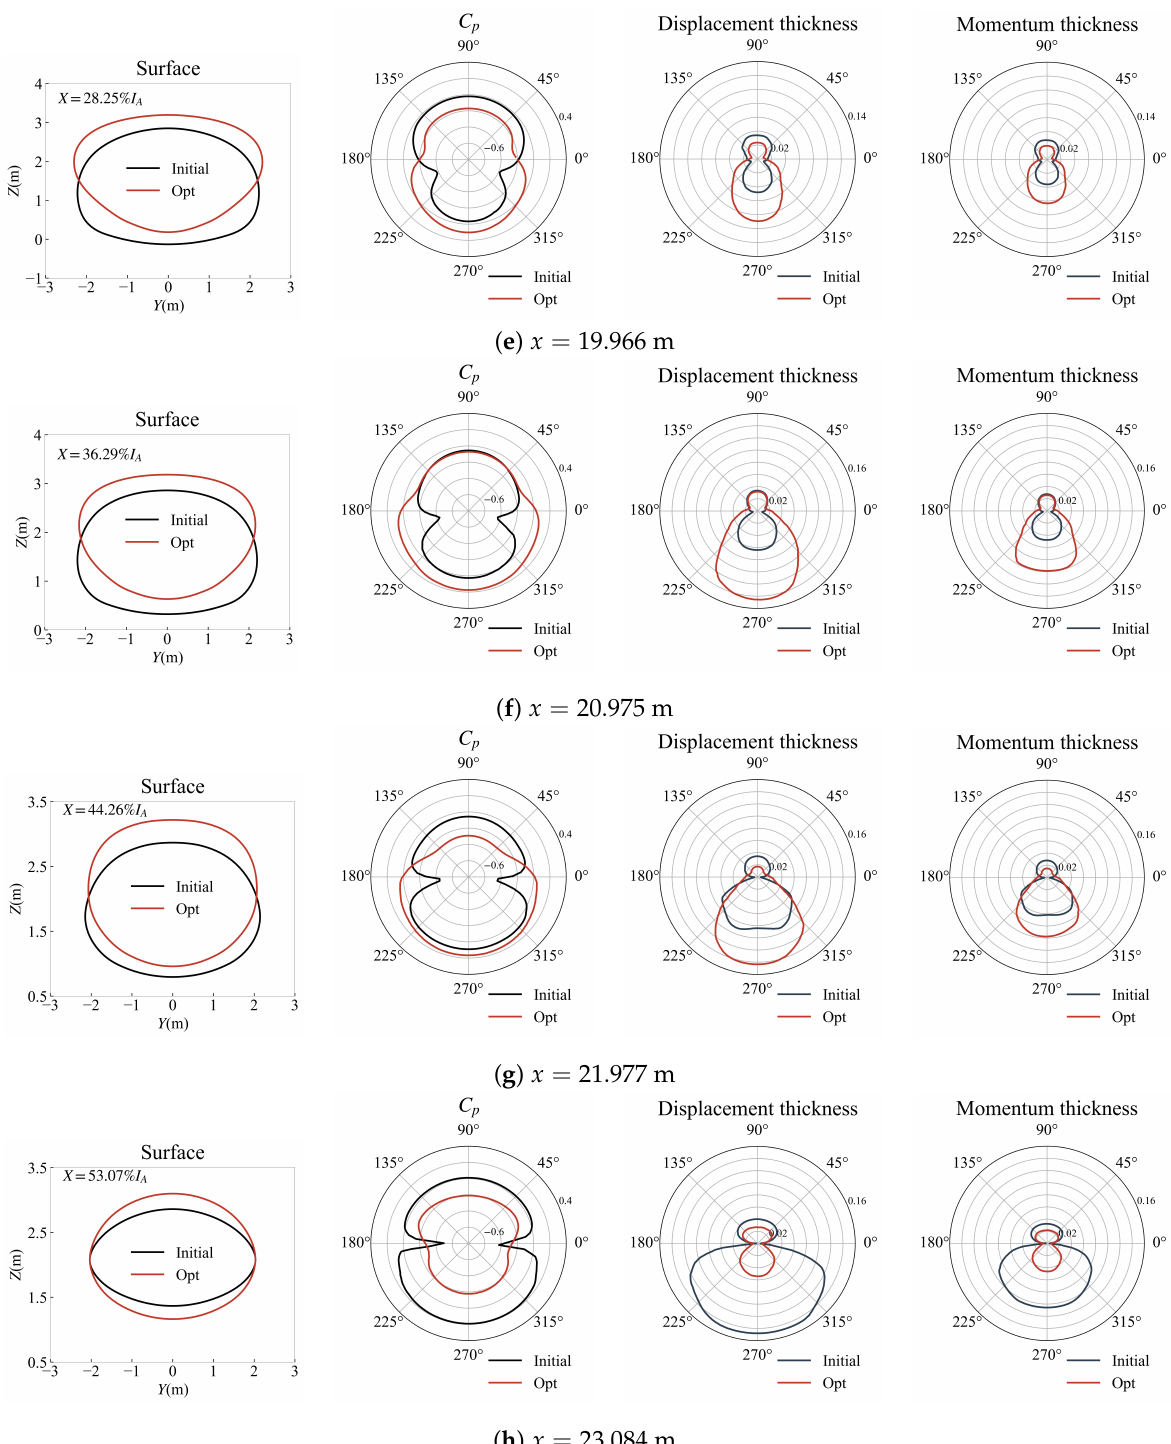
Figure 19. Comparison of surface, pressure coefficient, displacement thickness, and momentum thickness in eight cross-sectional positions of military